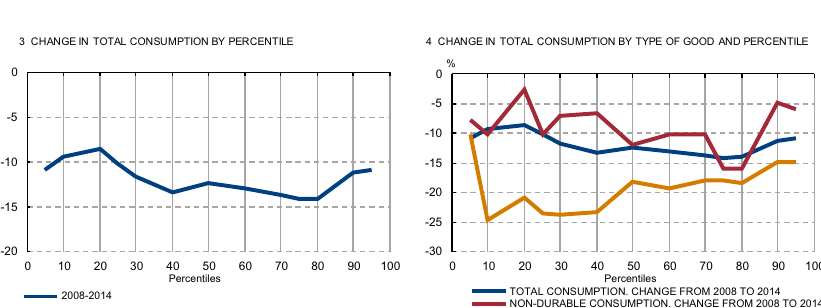
spending. Specifically, as shown in Panel 3 of Fig. 13, households in the percentiles below 20% of consumption spending suffered a decline in consumption of up to 10%, while households close to and above the median suffered a reduction of up to 14%. The inequality in total consumption dropped slightly in the lower part of the consumption distribution, while remaining virtually unchanged above the